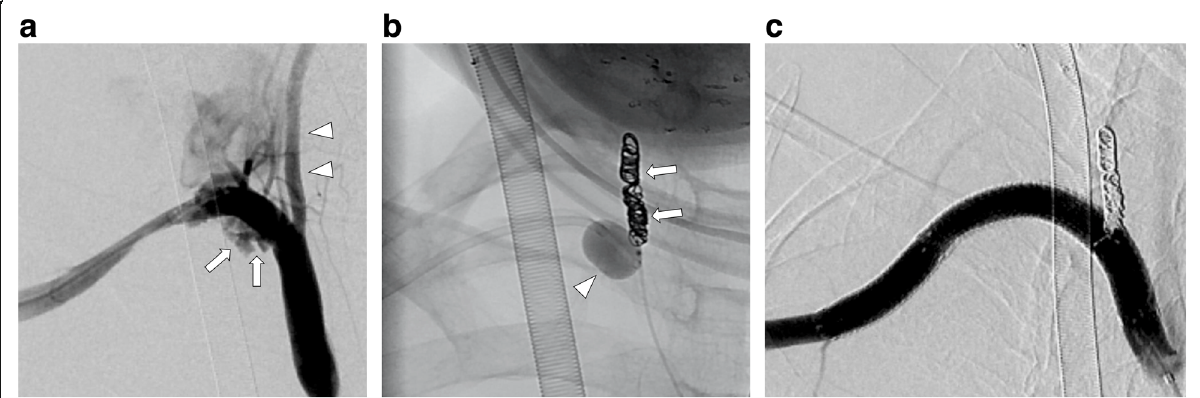
Fig. 1 A 64-year-old woman with right subclavian artery injury by an inadvertent puncture. A Pre-treatment angiogram shows extravasation from the proximal site of the right subclavian artery (arrows). The right vertebral artery branches close to the extravasation (arrowheads). B After confirming that the contralateral vertebral artery is patent and joins the ipsilateral vertebral artery, the right vertebral artery is embolized by coils (arrows) to avoid type 2 endoleaks under balloon occlusion (arrowhead) of the right subclavian artery. C Angiogram after endovascular therapy with Viabahn stent grafts (8 mm × 5 cm and 8 mm × 10 cm) shows the disappearance of the extravasation without endoleak